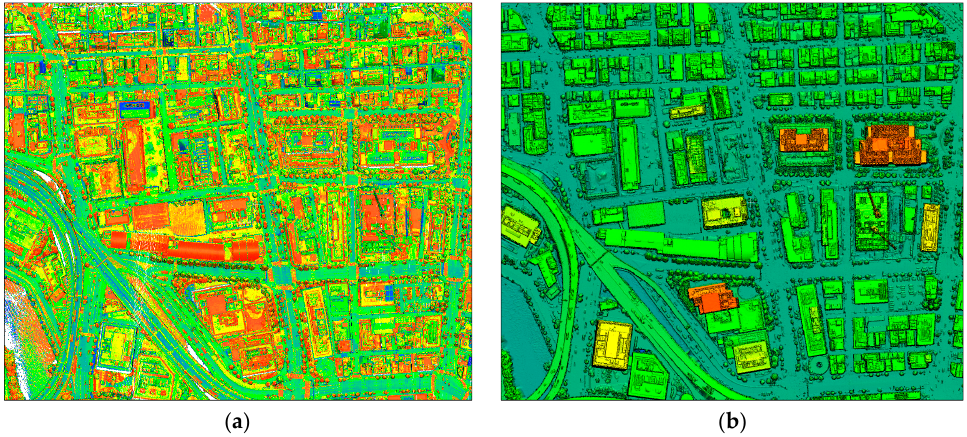
Figure 4. DSM reconstruction from ALS by 2.5D Delaunay triangulation: ( a ) input ALS point cloud (color denotes intensity); and ( b ) reconstructed DSM mesh (color denotes height).